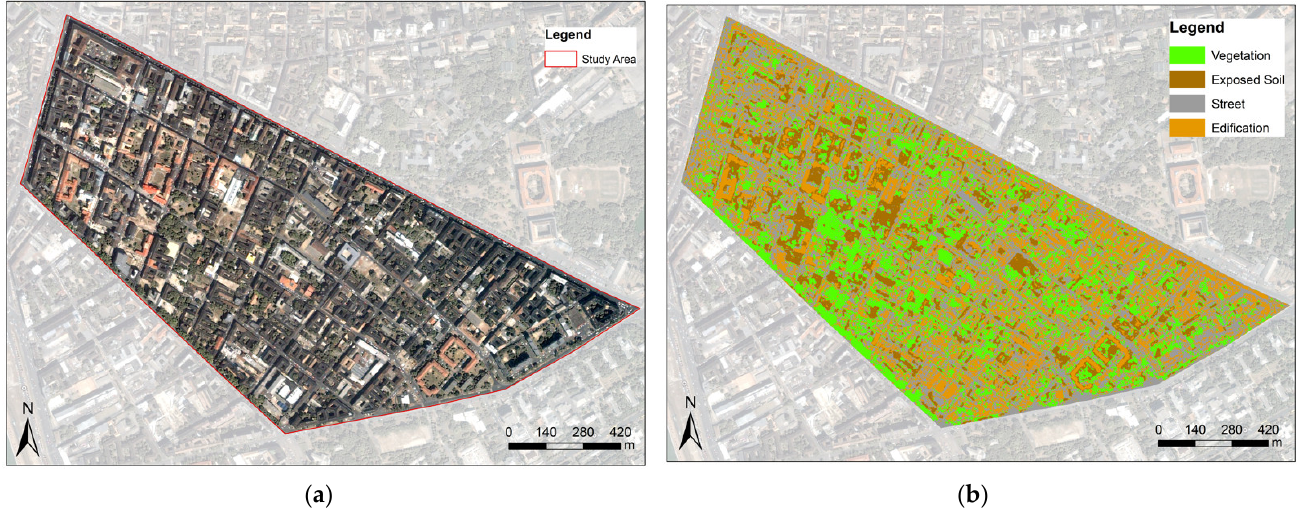
Figure 3. ( a ) Satellite image from the 2000s. It is possible to notice that most buildings have typological characteristics common to historic structures, which reverberate in the dense urban condition, despite the existent industrial voids.; ( b ) The supervised classification reveals urban fragmentation and the deficiency of green infrastructure in the